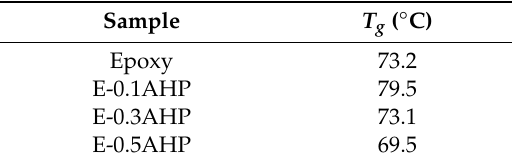
Table 4. Glass transition temperature of fully cured AHP / epoxy nanocomposites at β of 10 ◦ C.min − 1 .